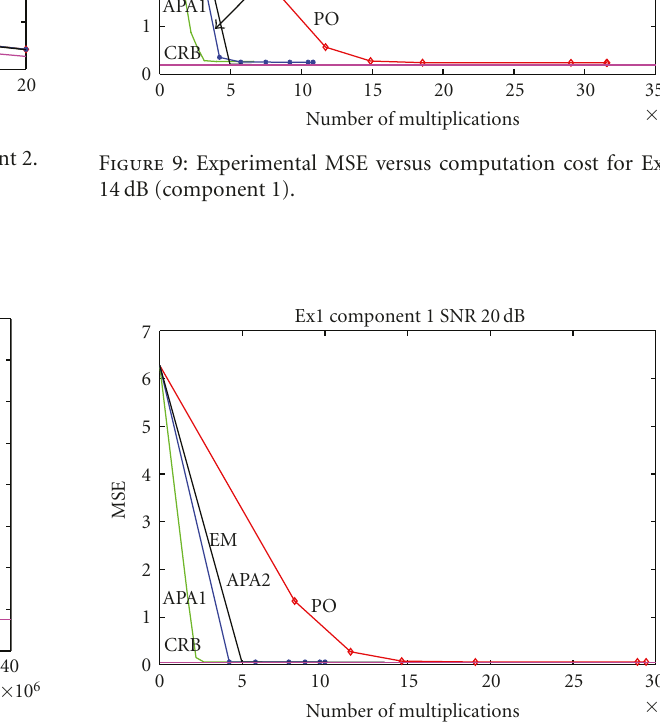
Figure 7: Experimental MSE versus computation cost for Ex1 at 8dB (component 1).